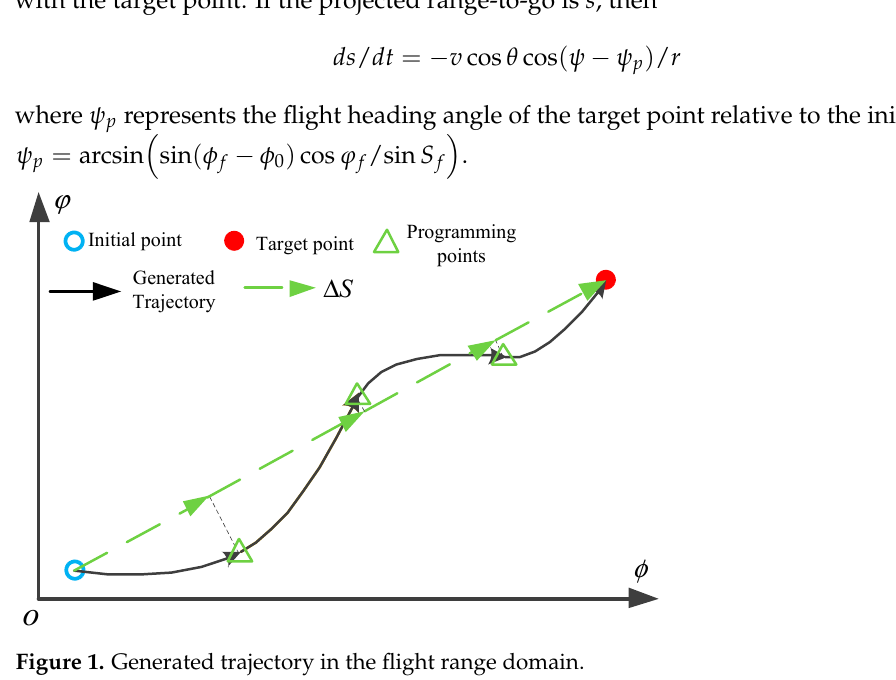
Figure 1. Generated trajectory in the flight range domain.